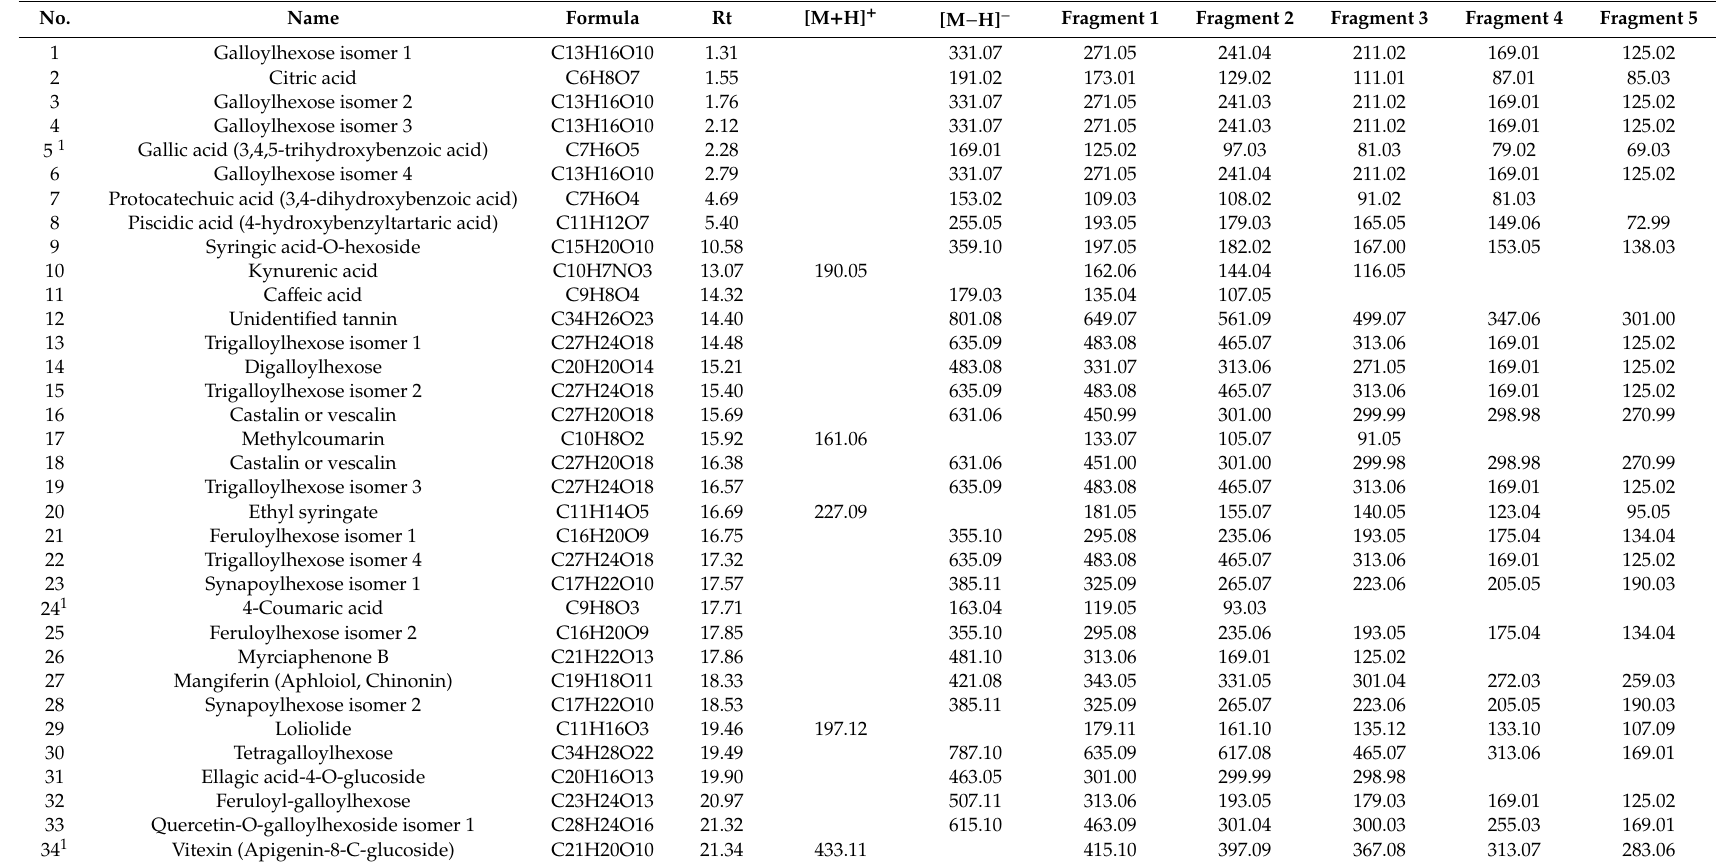
Table 6. Chemical composition of water